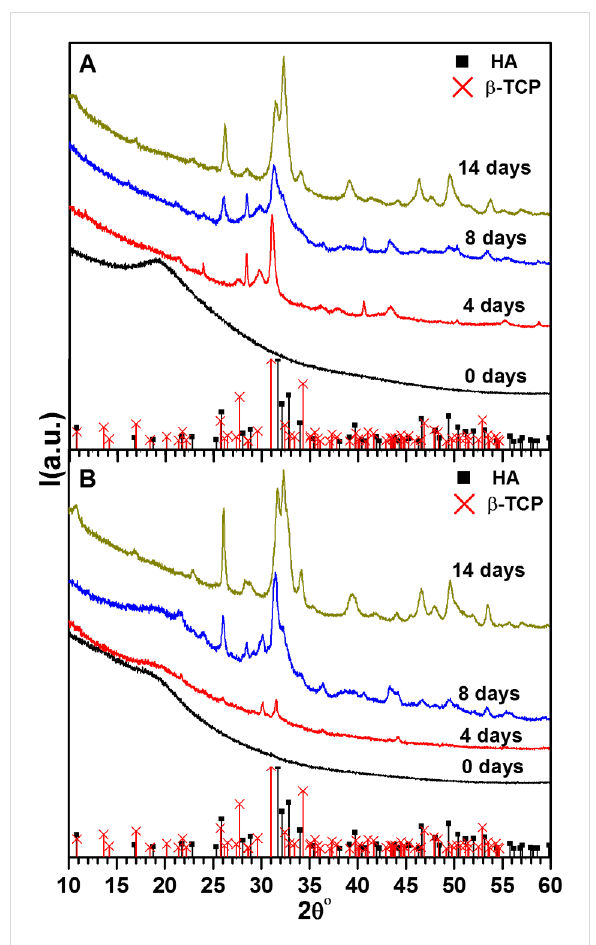
Figure 3: XRD patterns of mineralization products. (A) IK24 hydrogel, and (B) H3AH3 hydrogel after different incubation times. The XRD patterns of HA and β -TCP (bars) have been included for